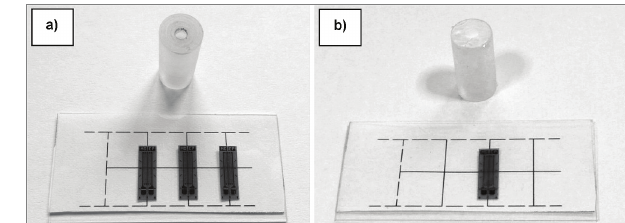
Fig. 3. Two types of sensors before gluing gauges: (a) for eccentric loading, (b) for axial